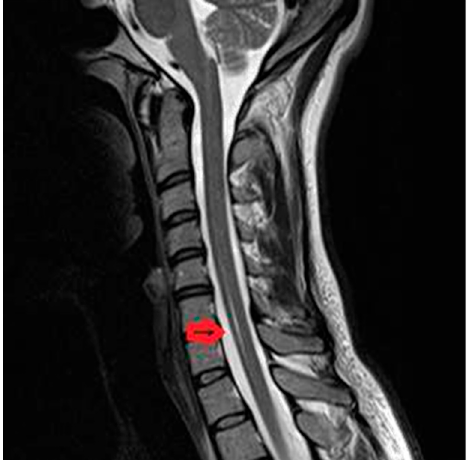
Figure 1. Description: Magnetic Resonance Imaging (MRI) shows a hyperintense signal on T2 ‐ weighted Turbo Spin Echo (TSE) sequence at C4 ‐ C7